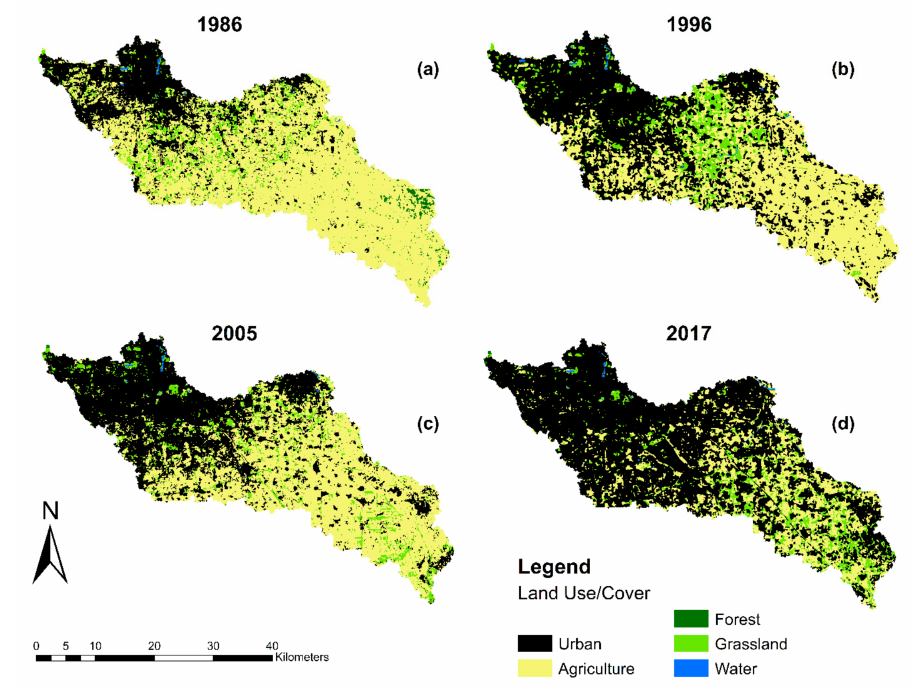
Figure 5. Land use/cover maps of the study catchment in ( a ) 1986, ( b ) 1996, ( c ) 2005, and ( d )